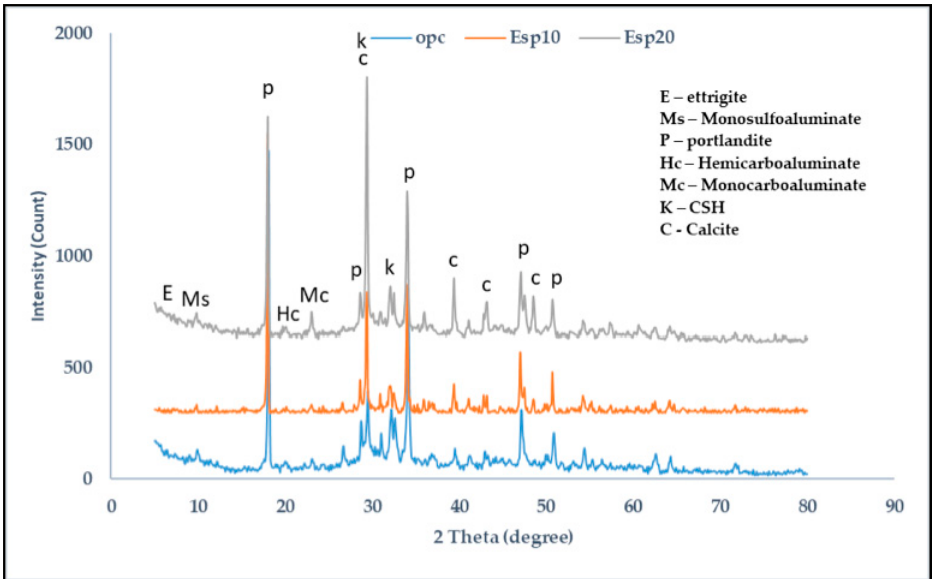
Figure 6. XRD analysis of 14-day cement paste.